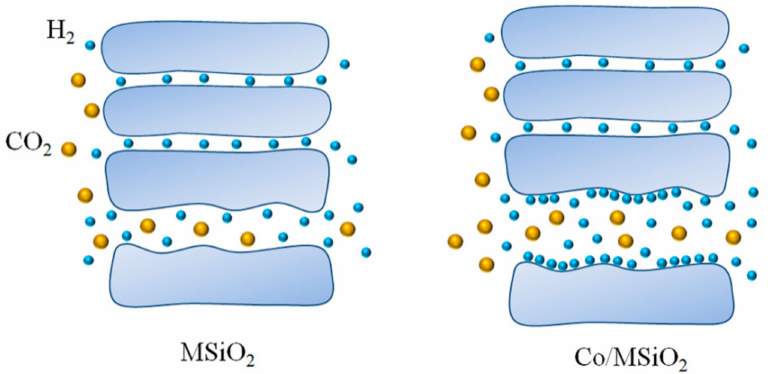
Figure 11. A possible schematic diagram for the change mechanism of supported MSiO 2 and Co/MSiO 2 membranes for separating H 2 /CO 2 .